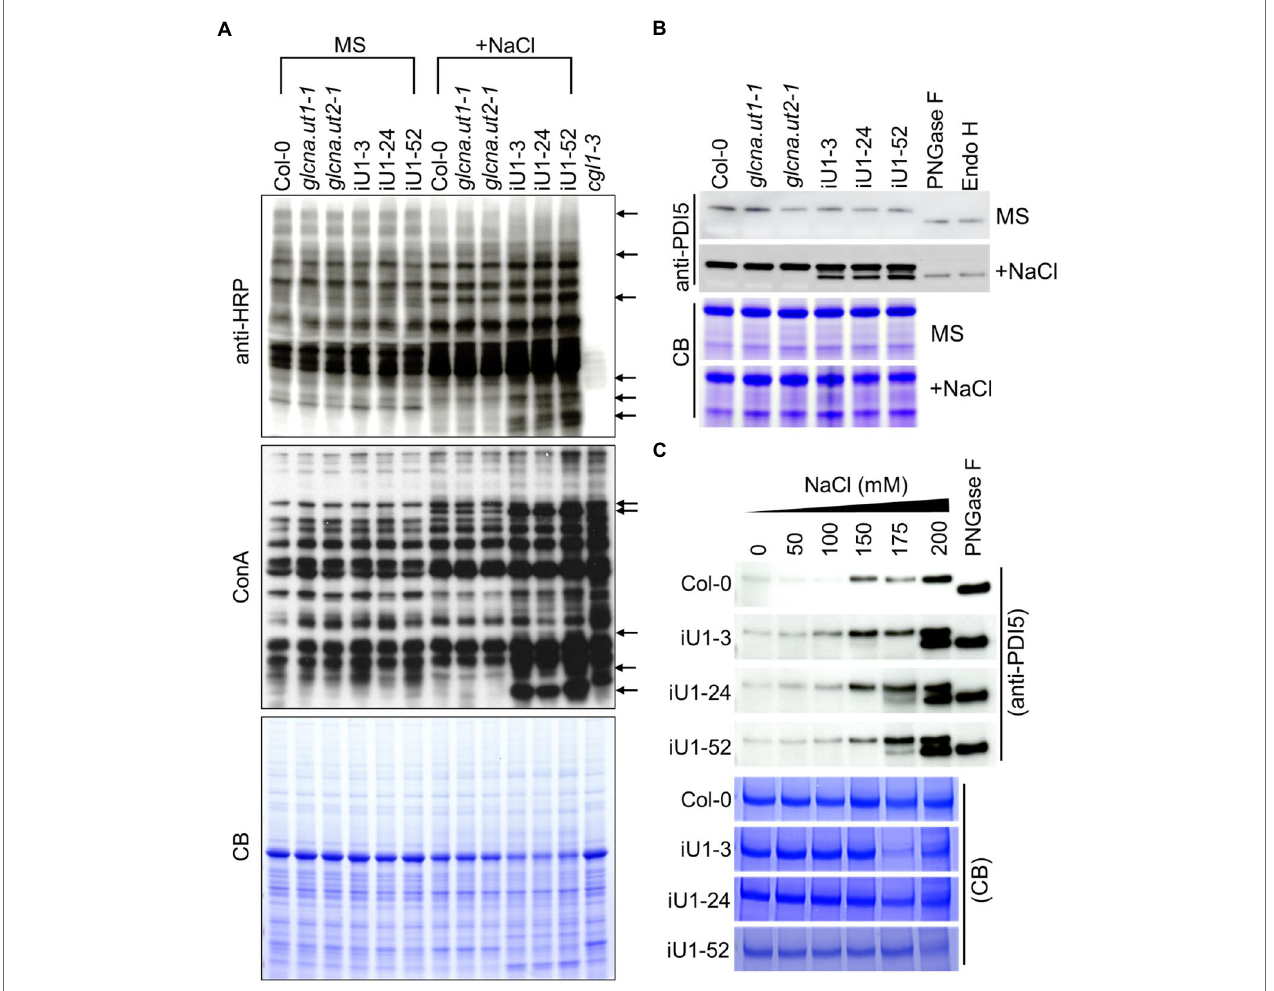
FIGURE 4 | Protein N-glycosylation is altered in iU1 seedlings under salt stress. (A) Immunoblot analysis of N-glycoprotein profiles. The blots were hybridized with anti-HRP antibody or ConA (Concanavalin A, a jack bean lectin). Arrows indicate variations in band intensity between Col-0 and the iU1 lines under salt treatment. The cgl1-3 mutant proteins were loaded as an N-glycosylation control. (B,C) Immunoblot analyses reveal the change in the glycosylated state of PDI5 under 200 mM NaCl (B) or other salt concentration treatments (C) . PNGase F and Endo H are enzymes that can remove N-glycan chains from glycoproteins and produce unglycosylated proteins. Total proteins were extracted from 14-day-old seedlings subjected to NaCl treatment. At least three independent experiments were performed in this study, and consistent results were obtained. Coomassie blue (CB) staining was used as a loading